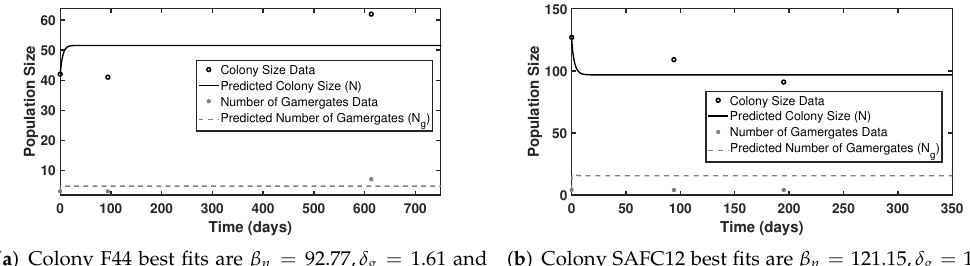
( a ) Colony F44 best fits are β n = 92.77, δ g = 1.61 and δ n = 0.37 Figure 4. Best Fits of model (9) and (10) for two different colonies: ( a ) F44 and ( b ) SAFC12 by fixing e = 2.42, d g = 0.00028, d w = 0.0025, and β g =